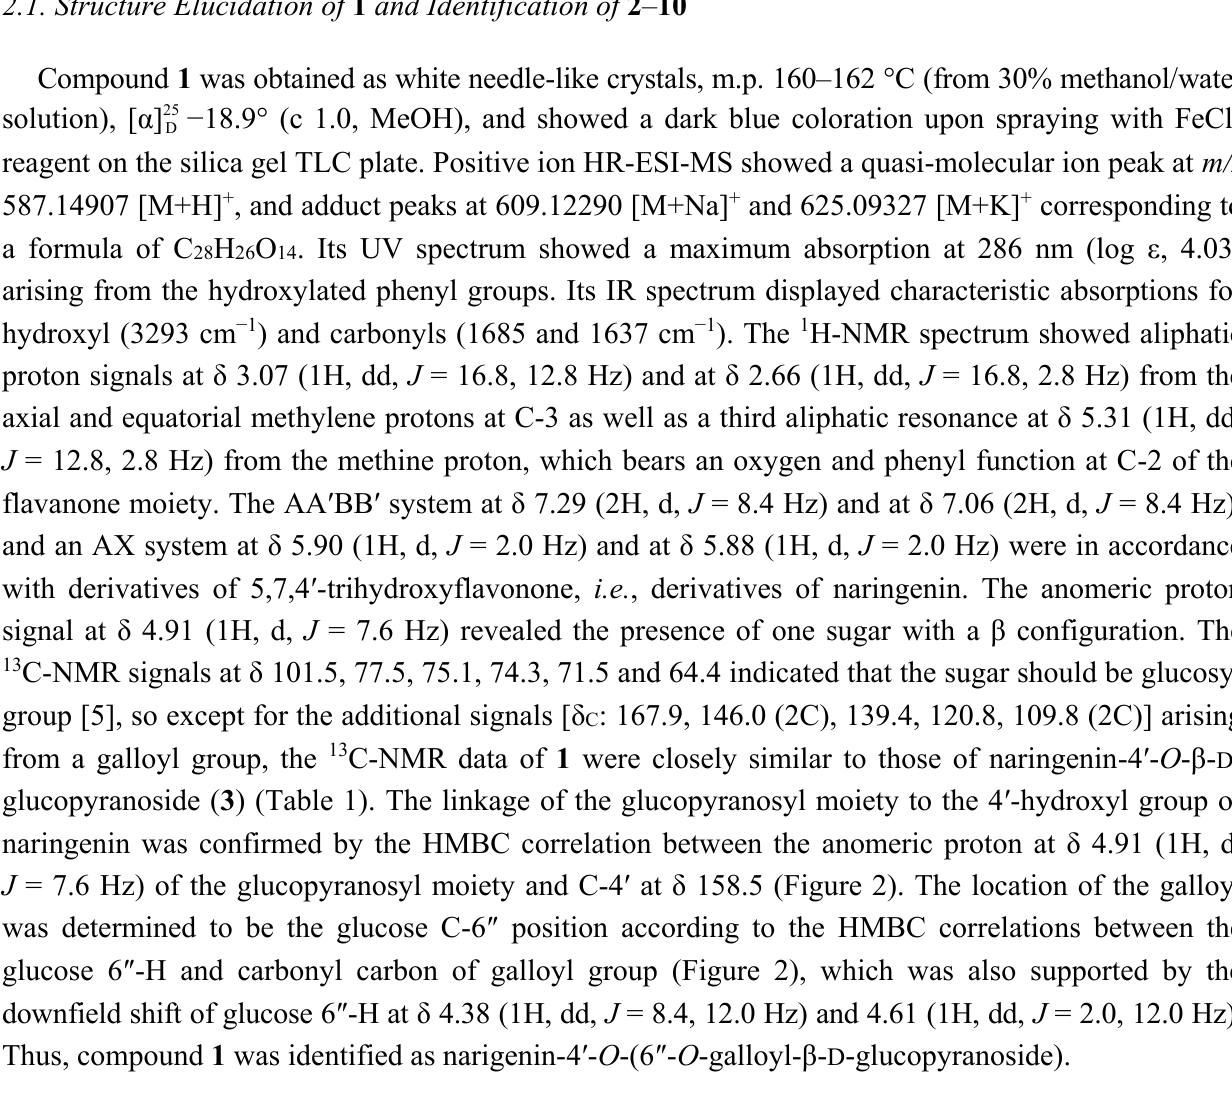
Figure 2. Structure and the HMBC correlations of 1